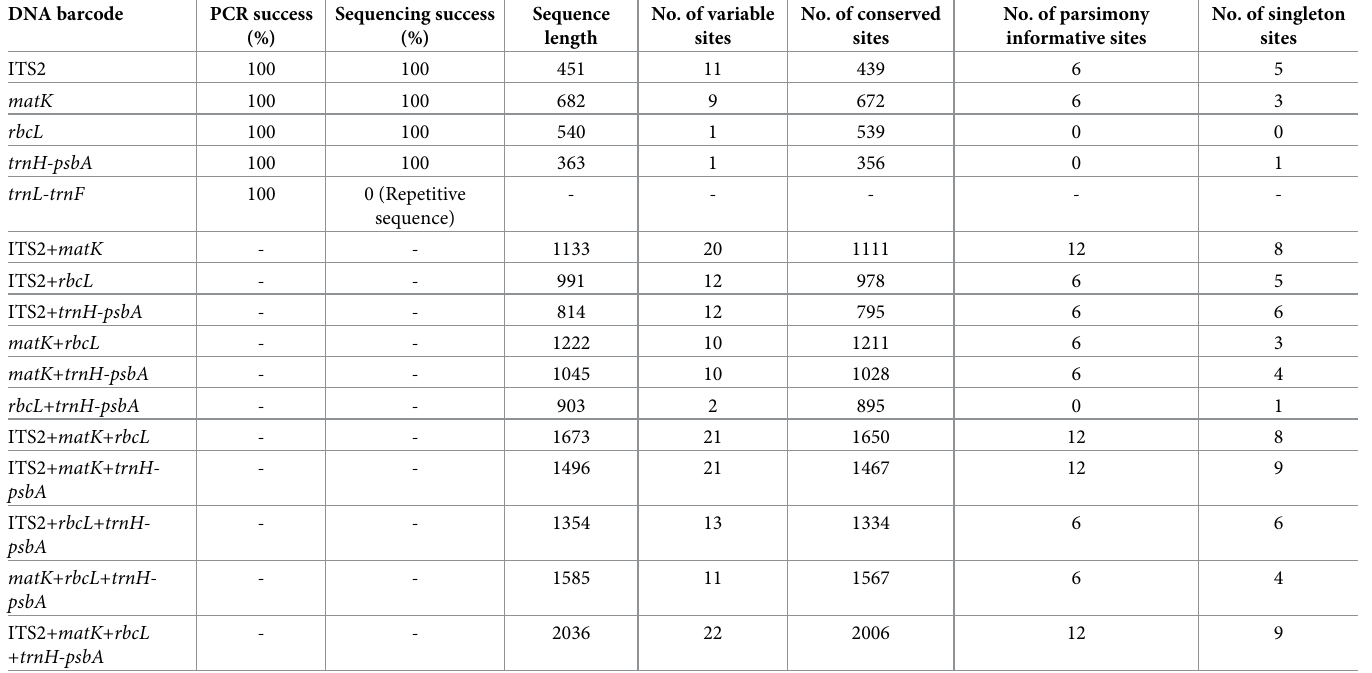
Table 2. Evaluation of the five DNA barcode loci. DNA